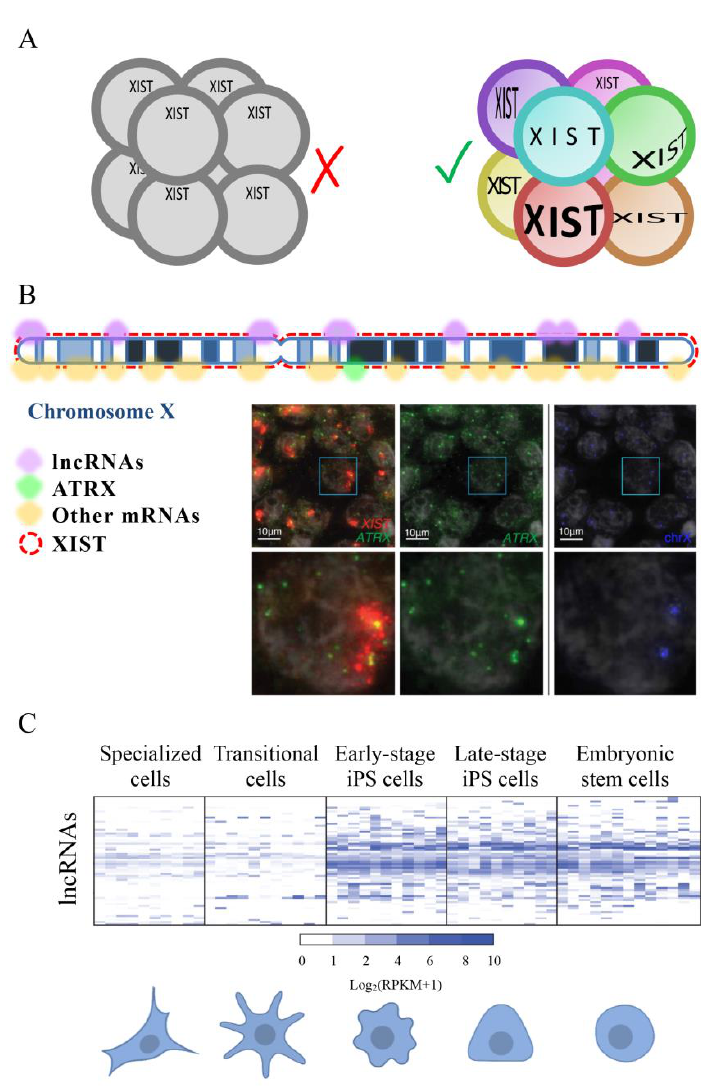
Figure 4. ( A ) Single-cell RNA sequencing of 8-cell embryos revealed that, contrary to what was previously believed, each cell has a different set of expressed genes and that the expression of XIST is not equal in the eight cells. ( B ) A scheme of an inactivated X chromosome with lncRNA XIST represented by red rectangles. Some genes are transcribed from this chromosome even if it is considered inactivated. Expressed lncRNAs are represented by purple semicircles while mRNAs are shown in yellow semicircles. In green, it is marked the position of ATRX, one of the mRNAs that escape the inactivation of the X chromosome. Microscope images show the expression of XIST (red), ATRX (green) and the position of the two X chromosomes (blue). Moreover, it is represented an enlargement of a single nucleus (white rectangle) for each staining. FISH images are modified from [155] . ( C ) Differences in lncRNA expression between cells at different stages of reprogramming. Some lncRNAs seem to be specifically expressed in the less specialized cells, suggesting that they might be involved with the maintenance of the pluripotency of stem cells and that might be used as tools to induce specialized cells to transition into less specialized cells (like iPSCs). Heat map is modified from [156] .